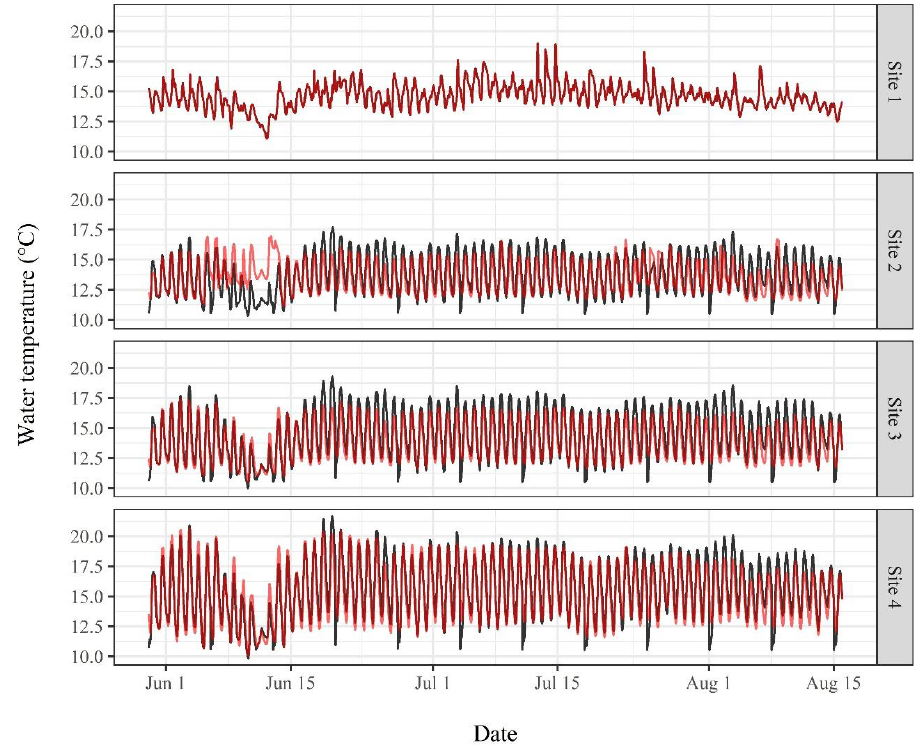
Figure 4. Plots of the modeled (black line) water temperature versus observed (red line) water temperatures for the weekly canopy growth simulation.